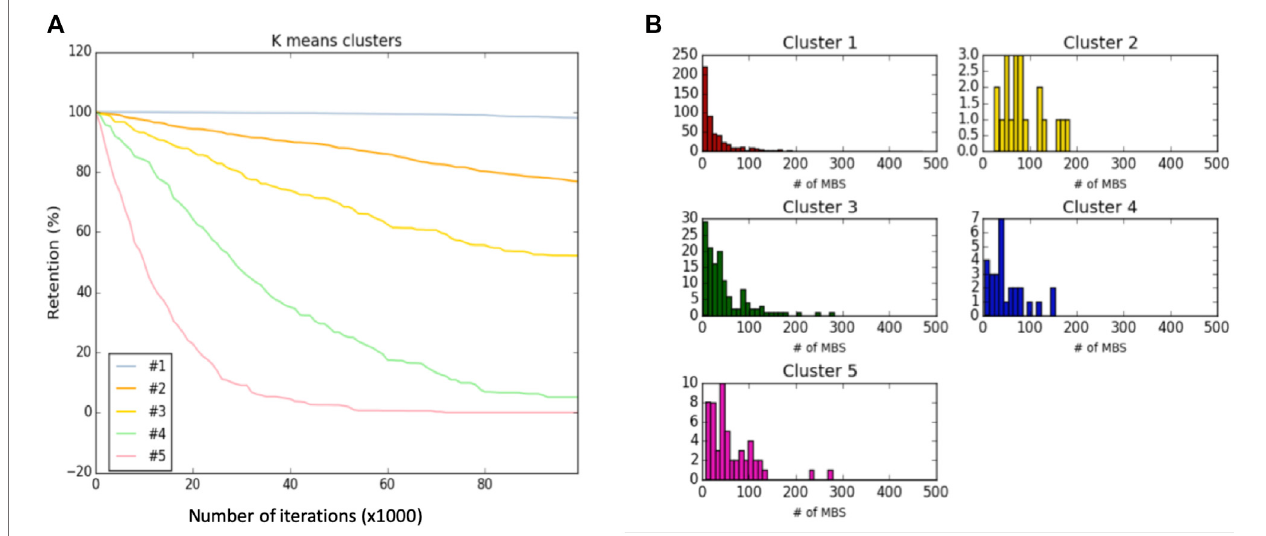
FIGURE4| Dynamicclassi fi cationandanalysis. (A) DynamicclassesofHelacellsalong100 kiterations ofasinglesimulationrun. (B) Thedistributionofnumberof MBS per gene in the 5 dynamic classes (Dyn-class).